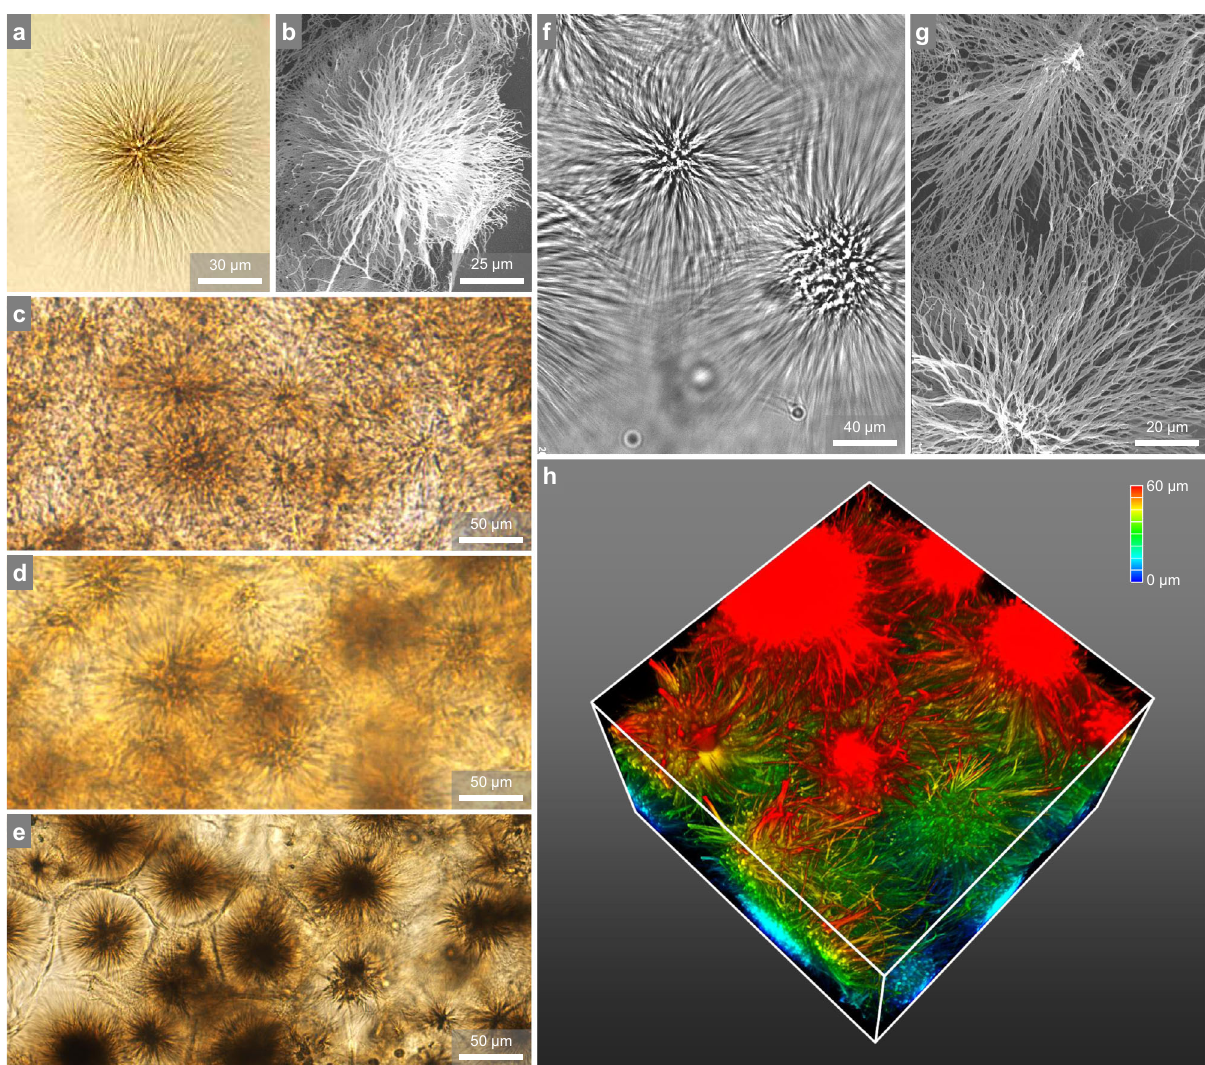
Fig. 2 Microstructures of asters and astral gels. a , b Images of single asters by optical microscopy ( a ) and SEM ( b ). c – e Densely packed asters in astral gels ( C = 1.5 wt% and ee = 0, 0.33, and 0.5, respectively). f , g Aster-aster interpenetration is highlighted by optical microscopy ( f ), SEM ( g ), and 3D reconstruction of CLSM ( h box size = 80 × 80 × 40 μ m, the color bar indicates the height in the z-